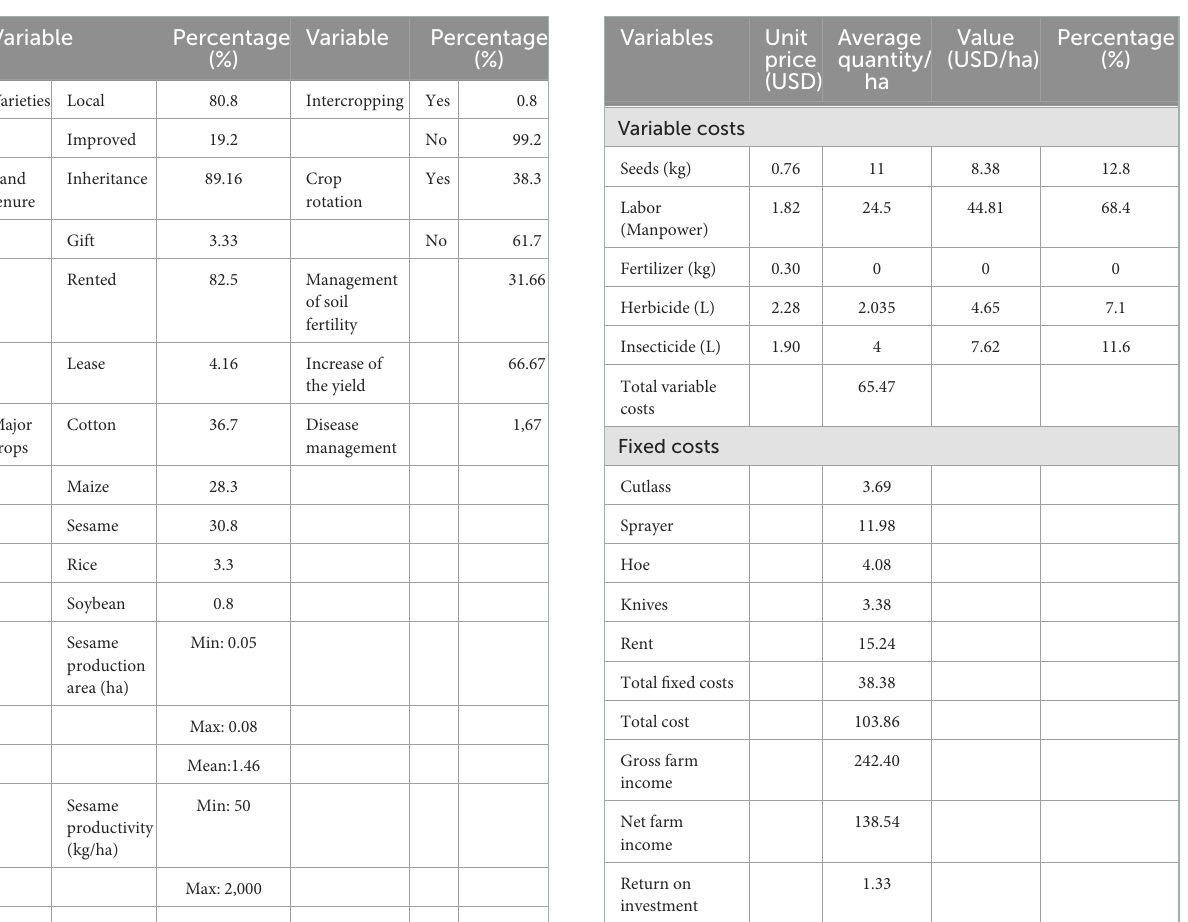
TABLE 4 Estimated costs and returns of sesame farming in the study